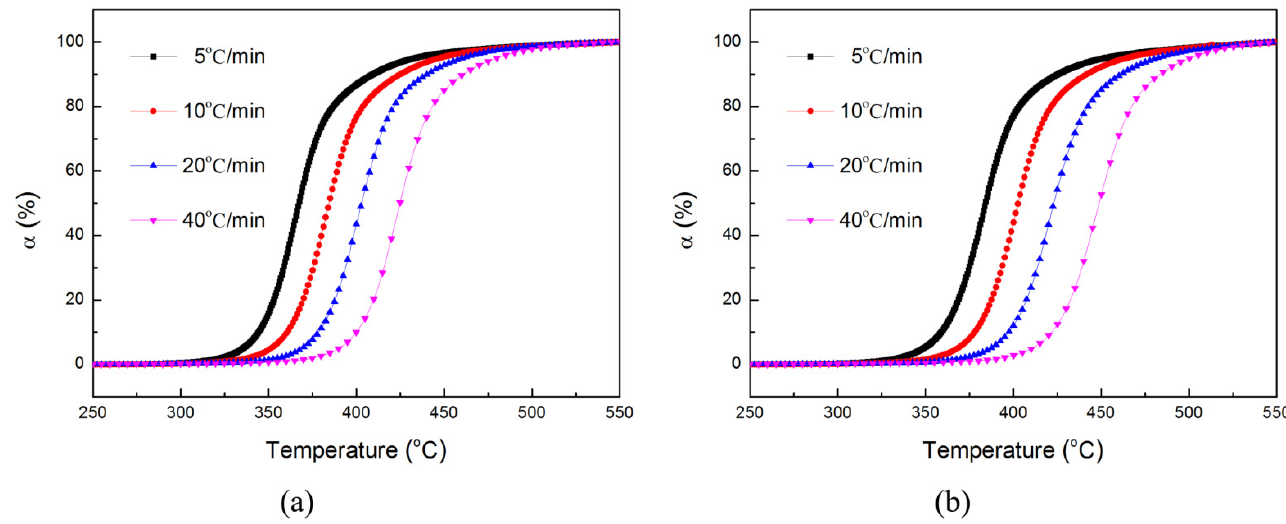
Figure 7. Conversion of ( a ) EP and ( b ) FREP in function of temperature.